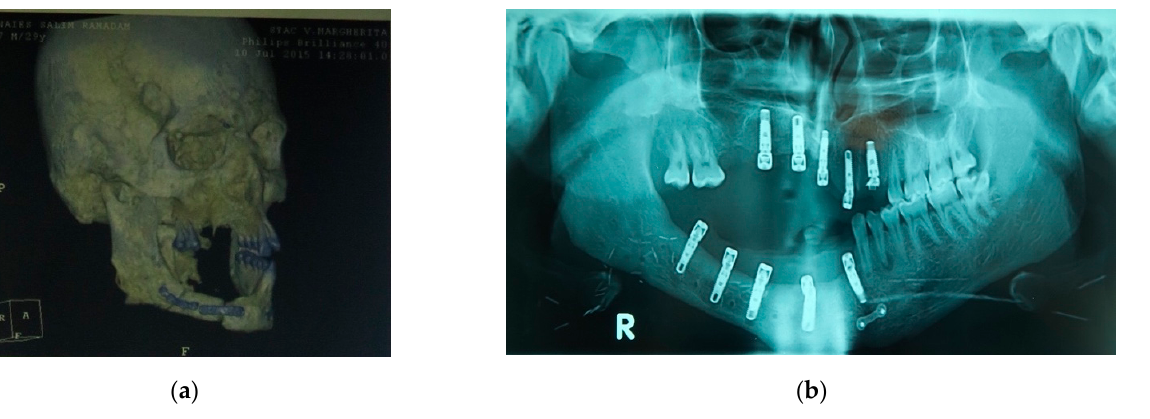
Figure 7. A 31-year-old male patient wounded by a high-velocity injury weapon. ( a ) Before prosthetic treatment; ( b ) after prosthetic treatment.